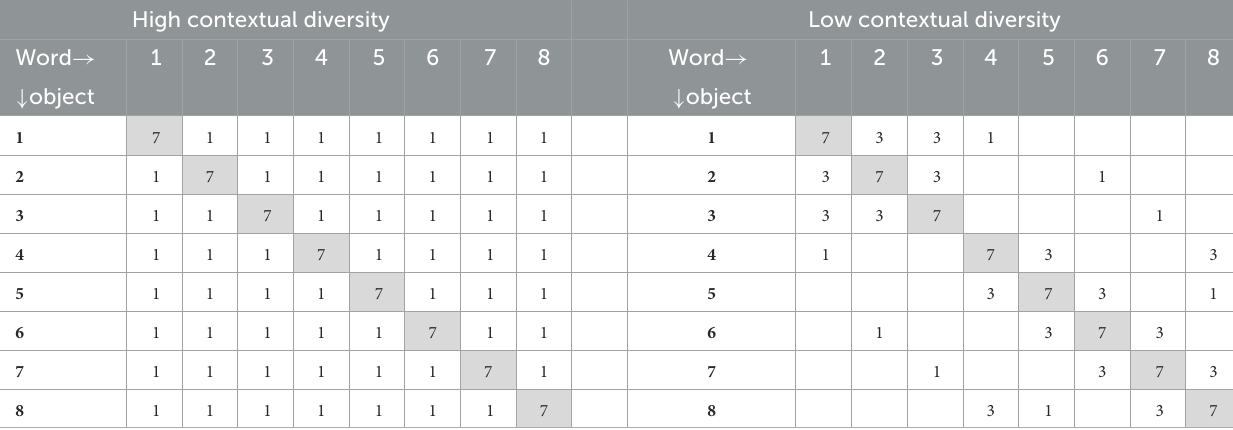
TABLE 1 High-CD and low-CD familiarization conditions. High contextual diversity